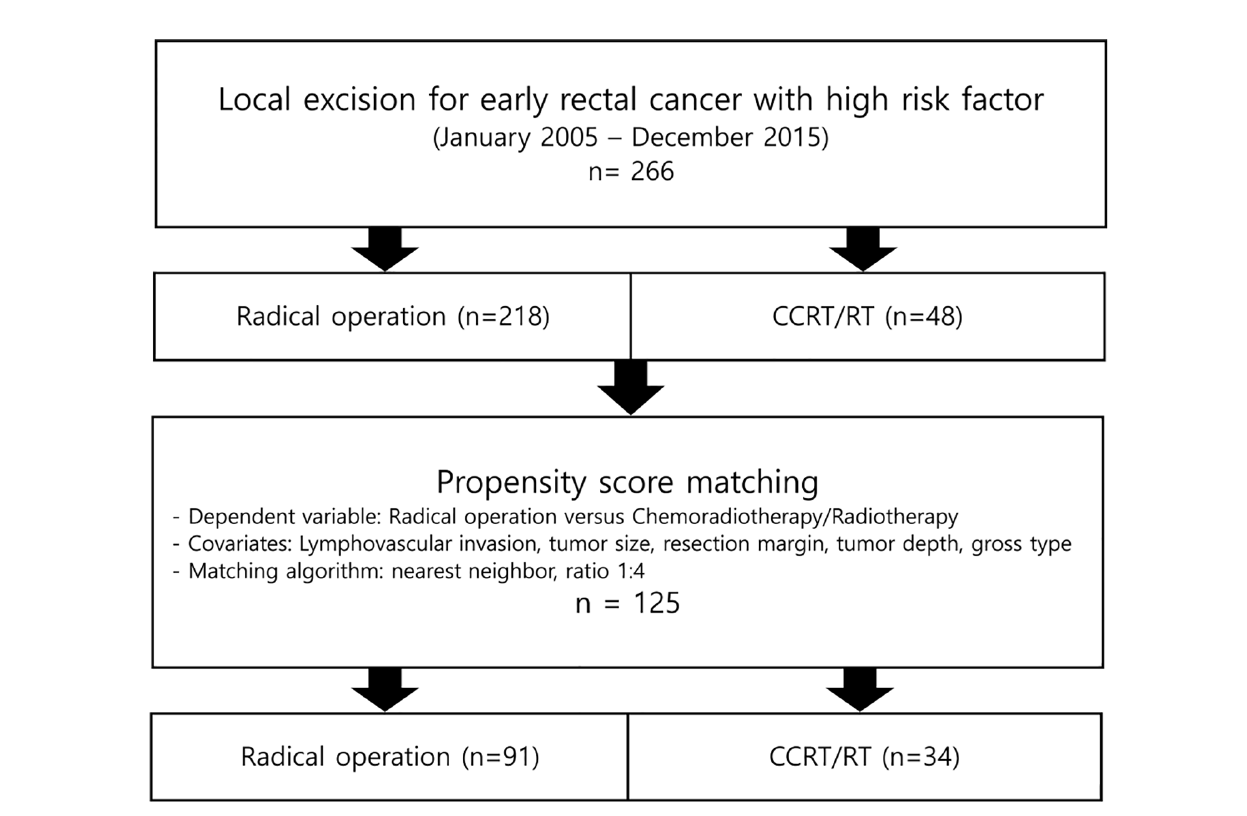
FIGURE 1 | Flowchart showing study population selection and matching by propensity